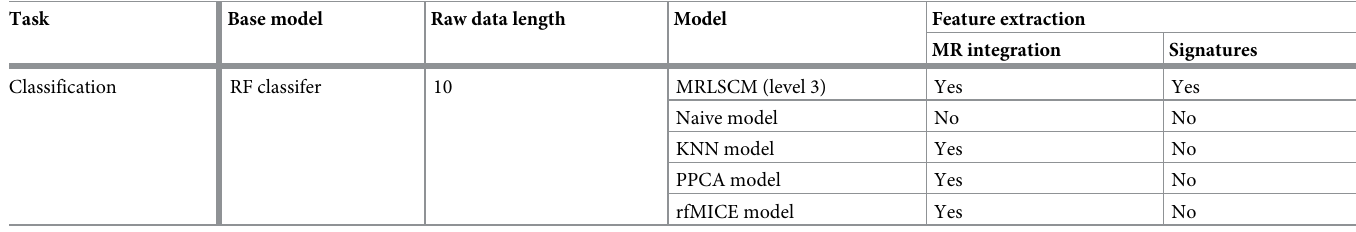
Table 2. A summary of models, where MR is short for missing responses, RF short for random forest.